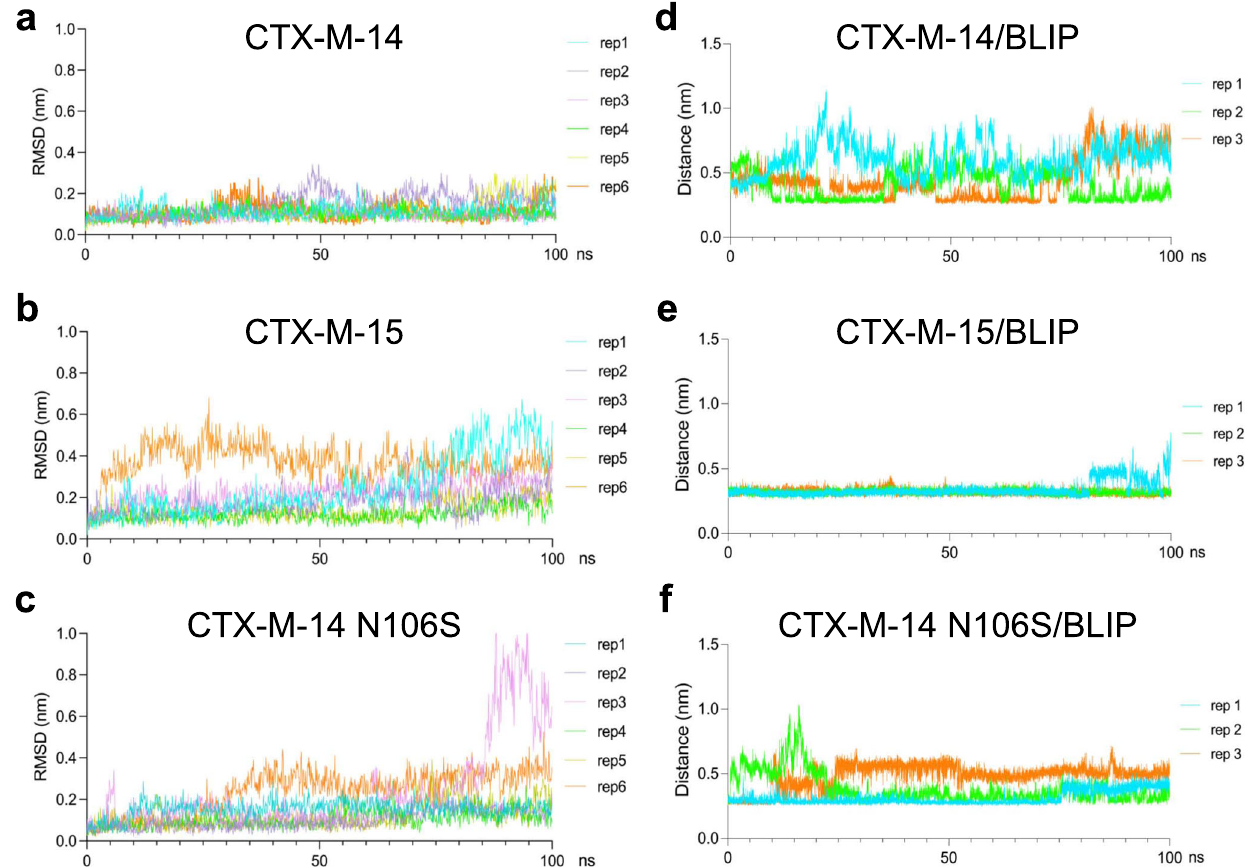
Fig. 7 | Molecular dynamics simulations of CTX-M apo-enzymes and CTX-M/ BLIPcomplexes.a TheRMSDofCTX-M-14loop103-106backbonethroughoutthe 100nsMDsimulations.Sixreplicatesimulationsareshown. b TheRMSDofCTX-M- 15 loop 103-106 backbone for six replicate 100ns MD simulations. c The RMSD of CTX-M-14 N106S loop 103-106 backbone for six replicate 100ns MD simulations. d The dynamic change of distance (nm) between CTX-M-14 Tyr105 backbone nitrogen and BLIP Glu73 side chain carboxylate oxygen atom throughout three replicate 100ns MD simulations of a modeled structure of CTX-M-14 in complex